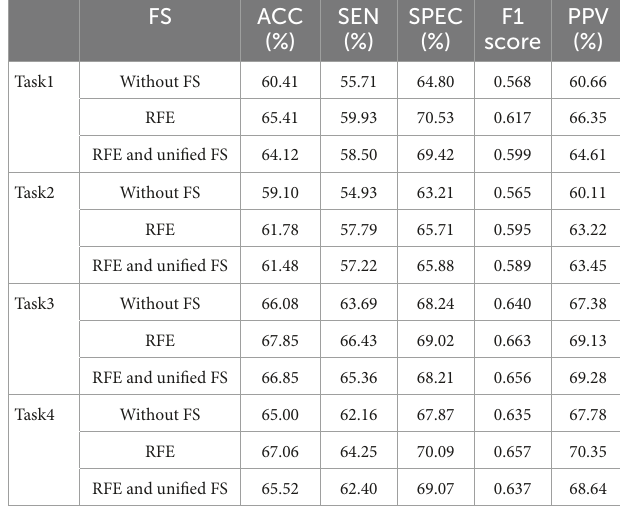
TABLE 8 The predictive performance of LR models combined with different FS